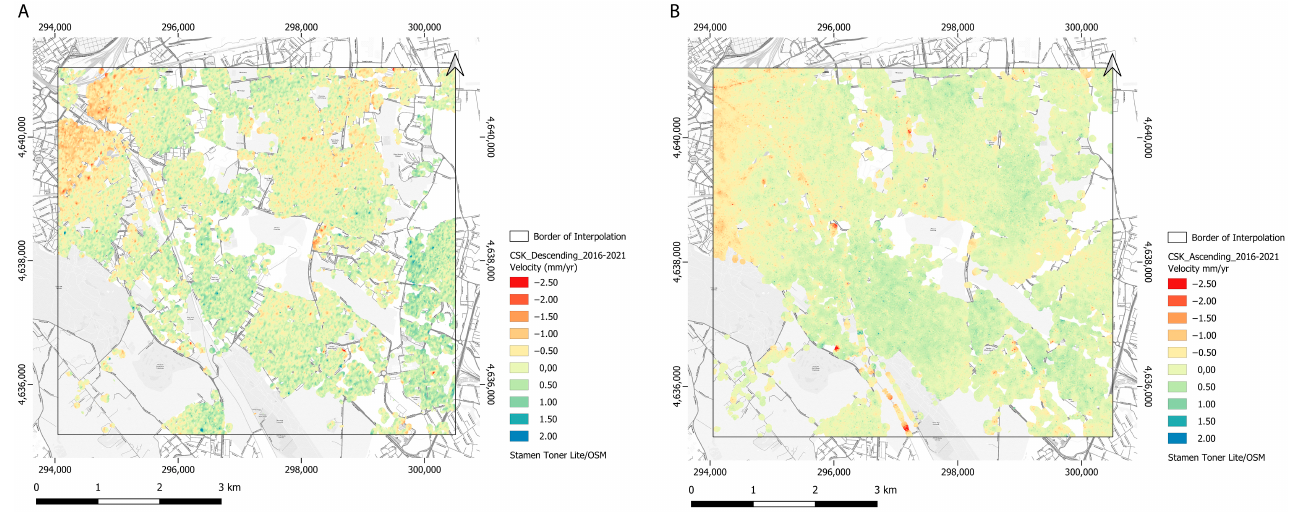
Figure 7. Velocity maps obtained from the interpolation of PSs (2016–2021), extracted from CSK Descending (RD, in picture ( A )) and Ascending (RA in picture ( B )) datasets. The color ramp and min/max values are set to show ad compare clearly the trends of Descending (RD, in picture A ) and Ascending (RA in picture B ) datasets.